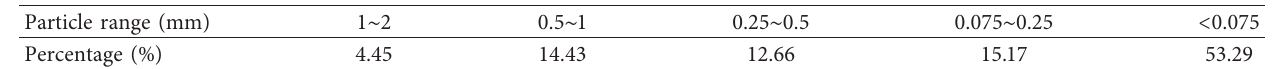
Figure 3: Table 1: Gradation of soil.